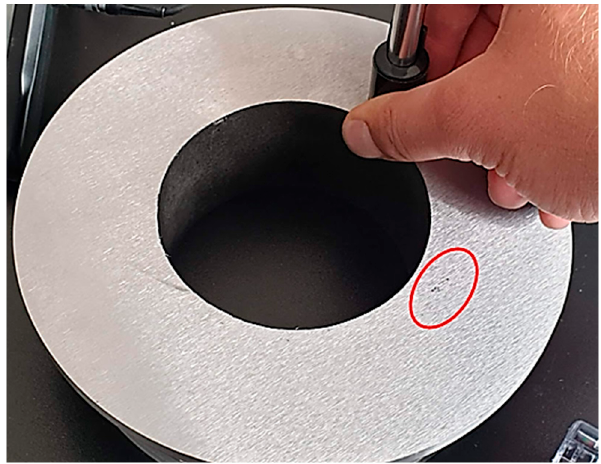
Figure 12. Presence of pores at the root layer, area inside of the red circle. Possible causes of pores in the layers: